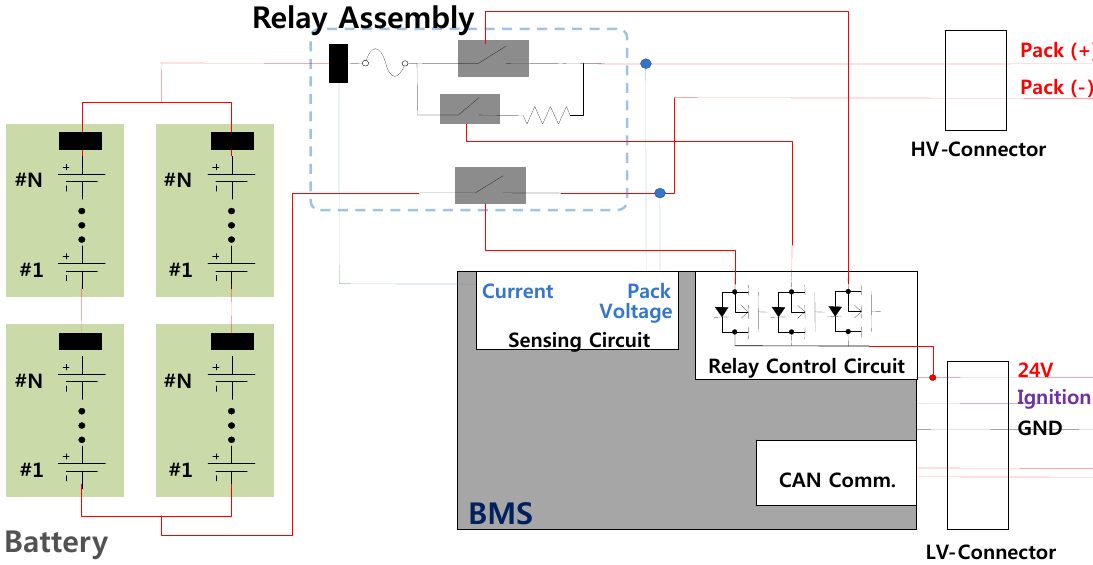
Figure 2. Configuration of the battery